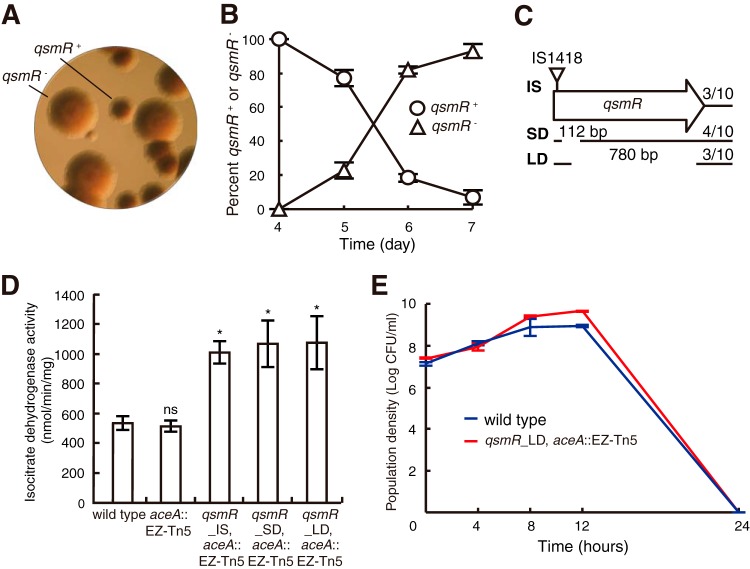
Morphological appearance of spontaneous glyoxylate cycle mutants. (A) Colonies of the spontaneous qsmR mutants were morphologically distinct from those of qsmR-positive (qsmR+) cells. Colonies were observed under a dissecting microscope at ×30 magnification. (B) The qsmR mutants appeared at day 4 after subculture and reached approximately 90% of the total viable population on day 7. (C) Among the 10 qsmR mutants characterized, 3 had an insertion of IS1418 at the 5′ end of the gene, and 4 and 3 had 112-bp and 780-bp internal deletions, respectively. Fractions at the right end indicate the frequencies of each type of mutant among the total 10 mutants. IS, SD, and LD indicate insertion, small deletion, and large deletion, respectively. (D) Isocitrate dehydrogenase activity in three types (IS, SD, and LD) of spontaneous qsmR mutants was higher than in the wild-type strain or the aceA mutant. (E) Fitness experiments comparing the wild-type strain and the spontaneous qsmR mutant_LD strain. The spontaneous qsmR mutant LD strain did not benefit from the presence of the wild type. Error bars represent the error ranges of experiments performed in triplicate. ns, no significant difference; *, P < 0.05.